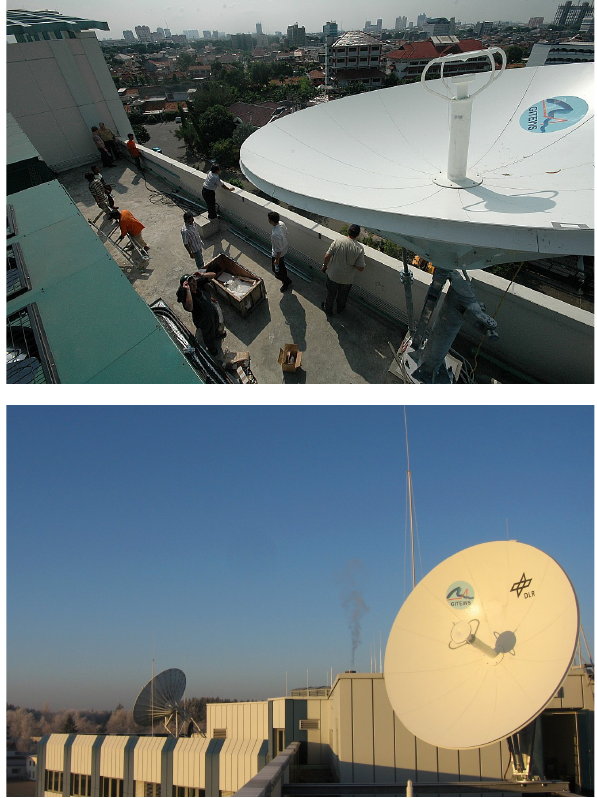
Fig. 13. The two VSAT antennas on the roof of BMKG headquar- ters in Jakarta (top) and on a building of DLR in Oberpfaffenhofen